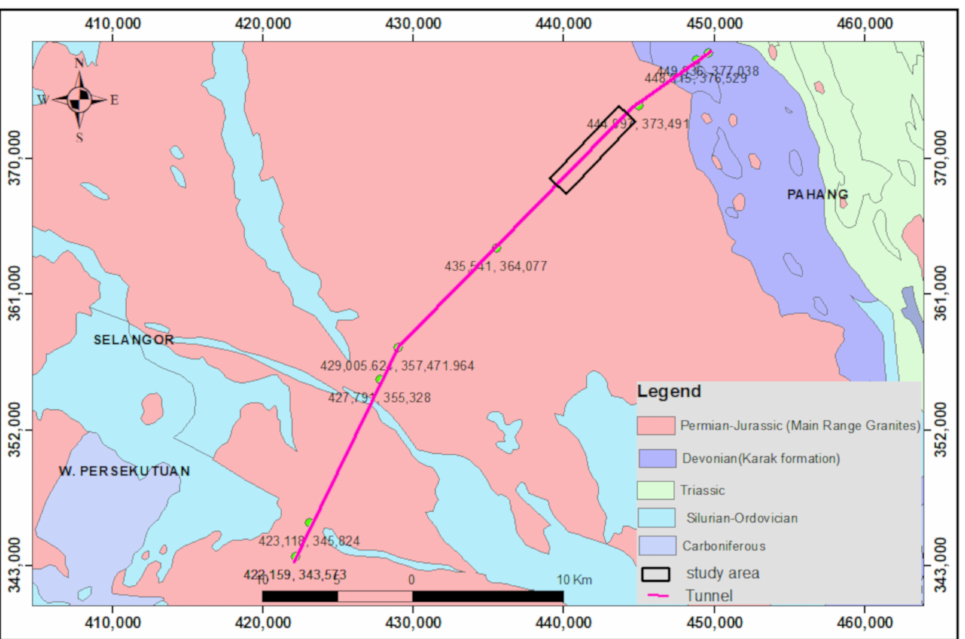
Figure 2. Geologic map of the study area.